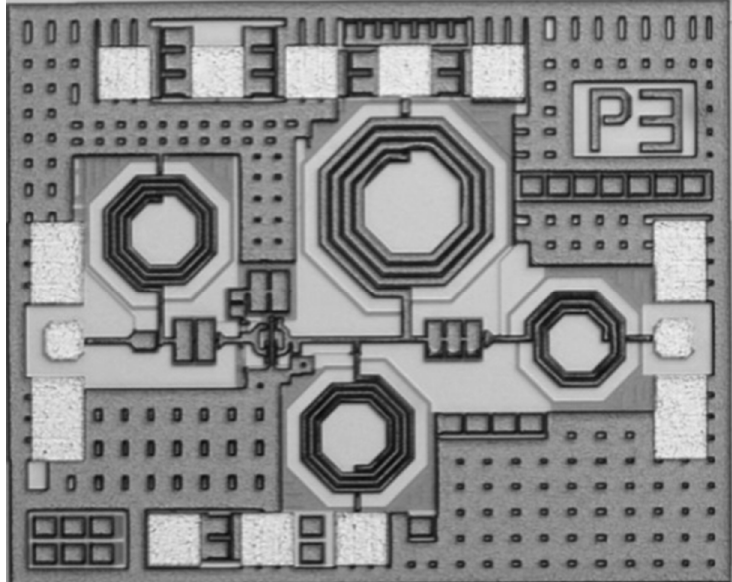
Figure 9. Photograph of the chip of the proposed circuits.